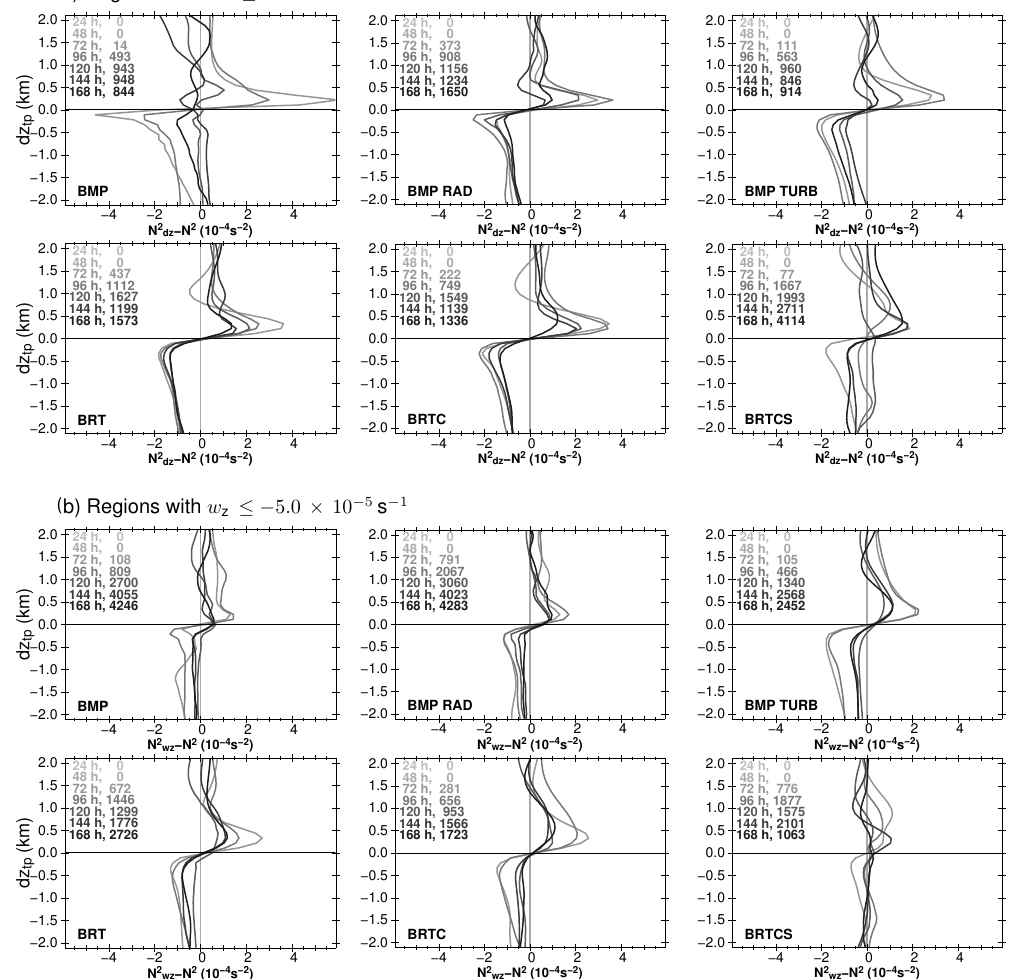
Figure 12. (a) Instantaneous thermal tropopause-based vertical profiles of difference between the mean of static stability in regions with (cid:49)z > 2 . 5km N 2 and the domain mean N 2 (in 10 − 4 s − 2 ) for each 24h of the model integration. (b) Differences for regions with ∂w/∂z ≤ d z − 5 . 0 × 10 − 5 s − 1 . The values in the top left corner of each panel show the number of individual profiles used for calculating the respective mean profile of N 2 and N 2 w z . d z tp is the distance to the height of the thermal d z